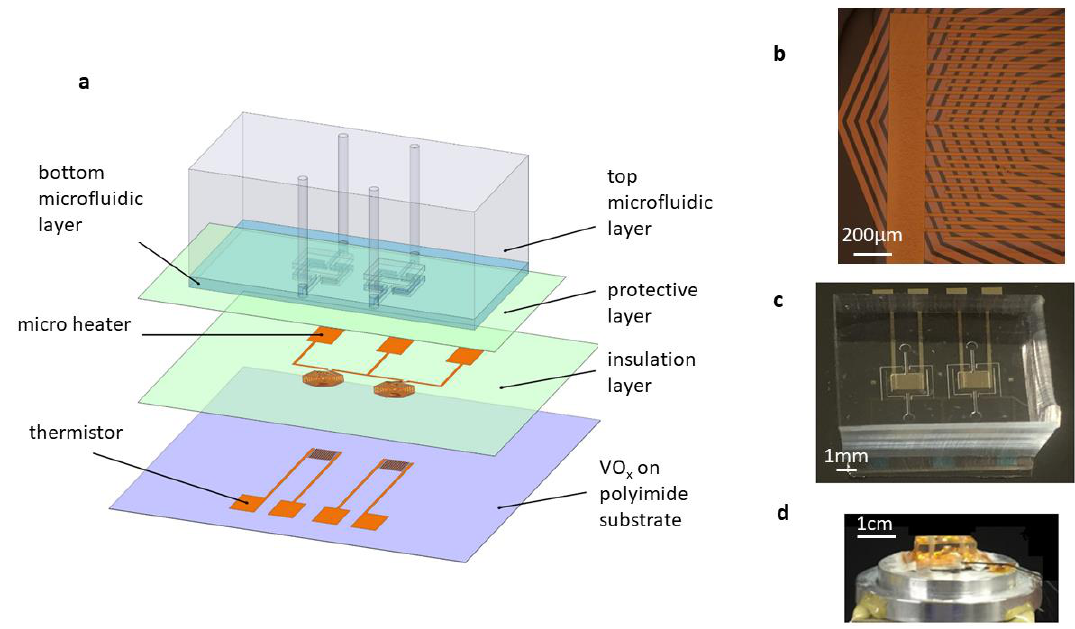
Figure 1. The MEMS DSC for the protein stability study. ( a ) Schematic diagram showing the components of the MEMS DSC. ( b ) Microstructure of the microheater and thermistor. ( c ) Prototype of the integrated MEMS DSC. ( d ) MEMS DSC placed on the heating stage for linear temperature scanning.